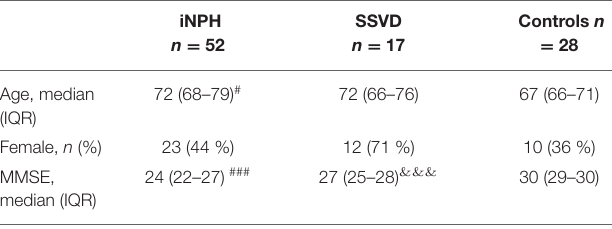
TABLE 1 | Age, sex, and mini-mental state examination (MMSE) in idiopathic normal pressure hydrocephalus (iNPH), subcortical small vessel disease (SSVD), and